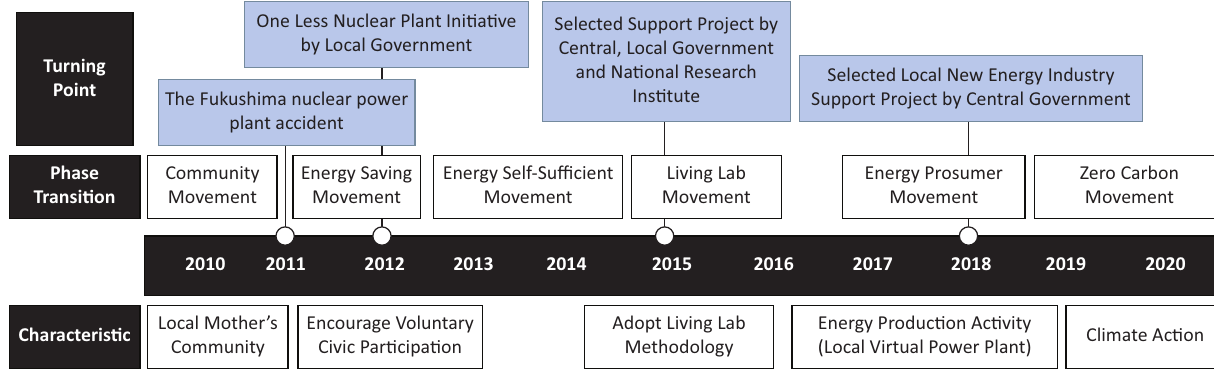
Figure 2. Timeline of SSL